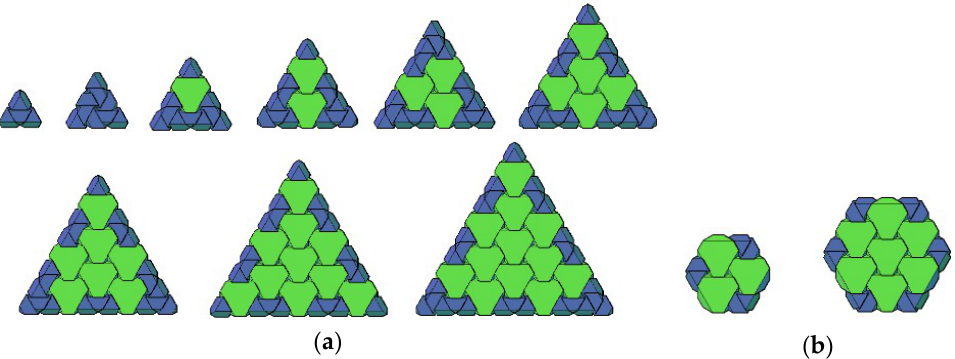
Figure 7. Slabs composed from hexagonal and triangular components: ( a ) triangular; ( b ) hexagonal.